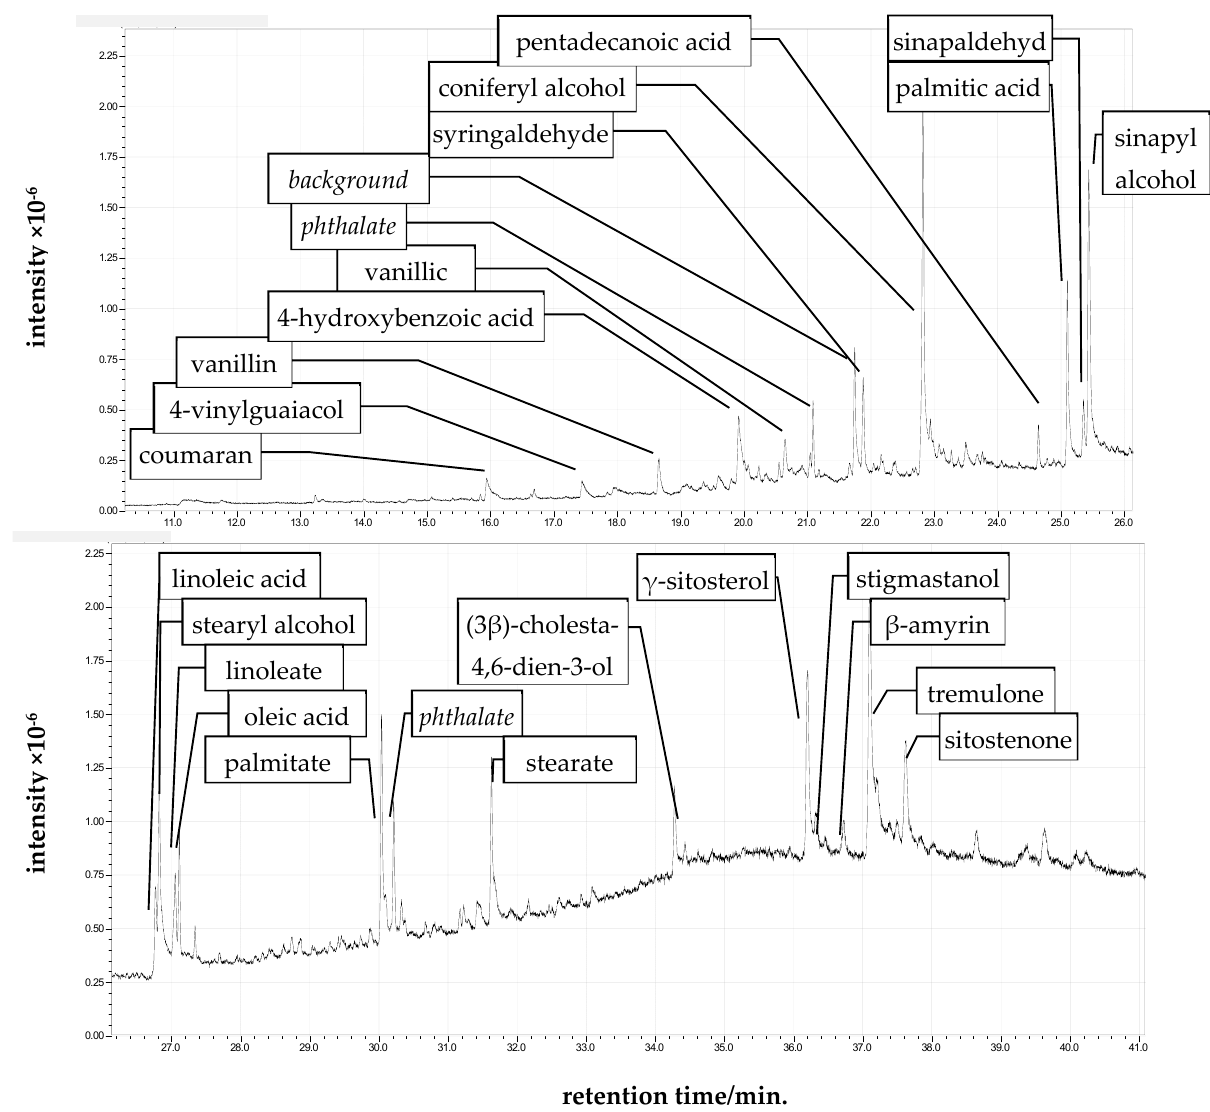
Figure 3. European aspen chromatogram ( P. tremula L.) with peak identification.